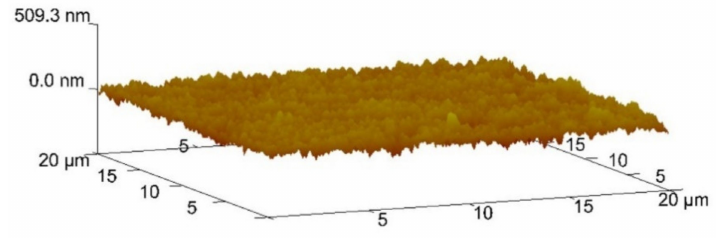
Figure 6. AFM topography analysis on the coated surface.